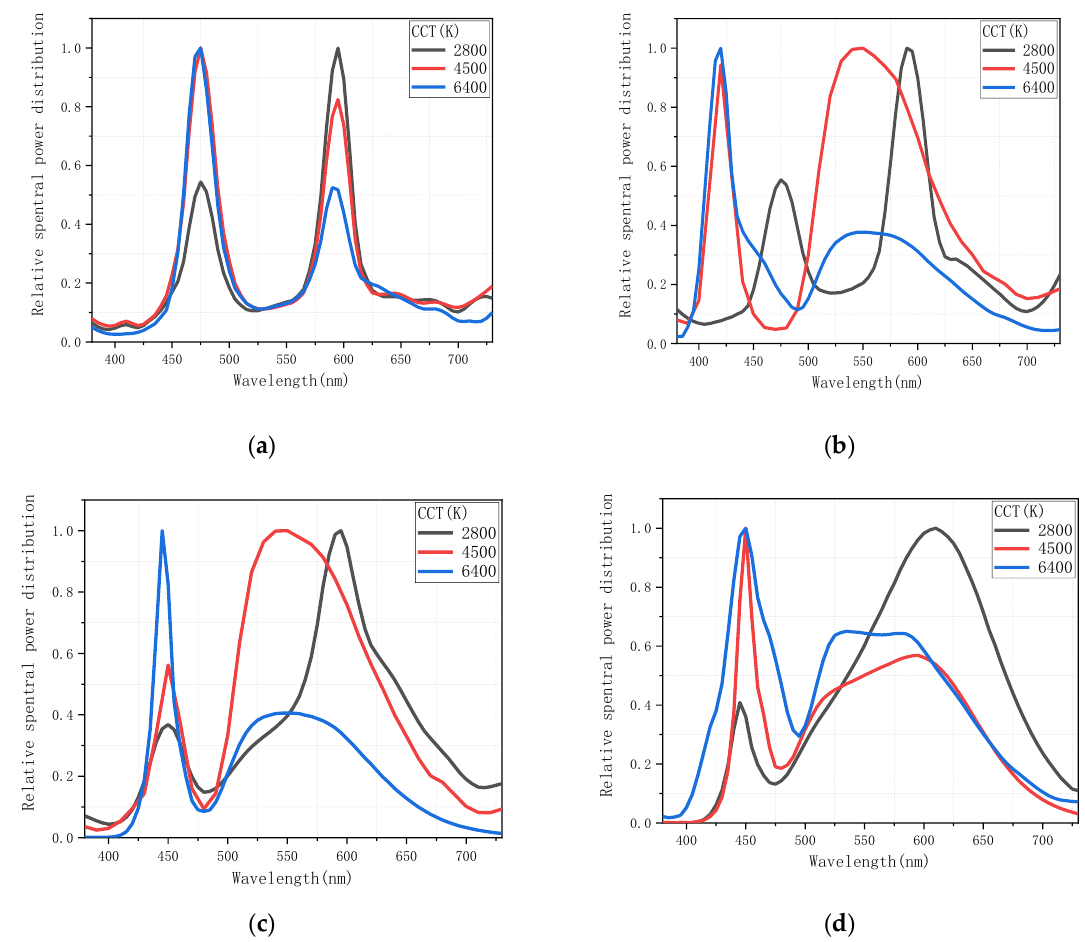
Figure 2. Relative spectral power distribution (SPD) of Light-Emitting Diodes (LEDs) with different CRI2012s (a color difference-based color rendering index) and LP-CCTs (the CCTs simulated by LEDcube). ( a ) CRI2012 = 55 ( b ) CRI2012 = 65 ( c ) CRI2012 = 75 ( d ) CRI2012 = 85.